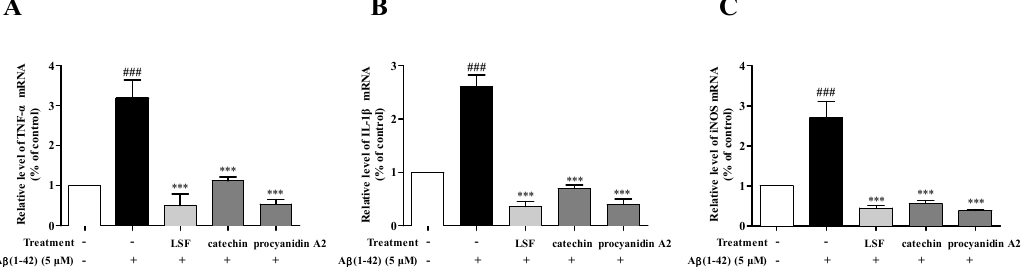
Figure 4. The mRNA levels of TNF-α, IL-1β, and iNOS in Aβ(1-42)-induced BV-2 cells under the treatments of LSF, catechin, and procyanidin A2. BV-2 cells were pretreated with 5 μM Aβ(1-42) for 12 h, followed by incubations of LSF (0.469 μg/mL), catechin (10 μM), and procyanidin A2 (10 μM) for another 12 h. After treatment, total mRNA were extracted and subsequently employed for TNF- α ( A ), IL-1β ( B ), and iNOS ( C ) measurements using RT-PCR. BV-2 cells treated with medium alone were set as the control group, and BV-2 cells treated with 5 μM Aβ(1-42) alone were set as the Aβ(1- 42) group. ### p < 0.001 vs. control group; *** p < 0.001 vs. Aβ group. Data are the mean value ± S.D. of five independent experiments.